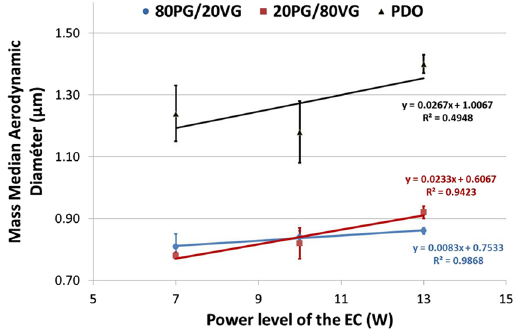
Figure 5. Impact of the power level of the EC on the Mass Median Aerodynamic Diameter (MMAD). Experiments performed in